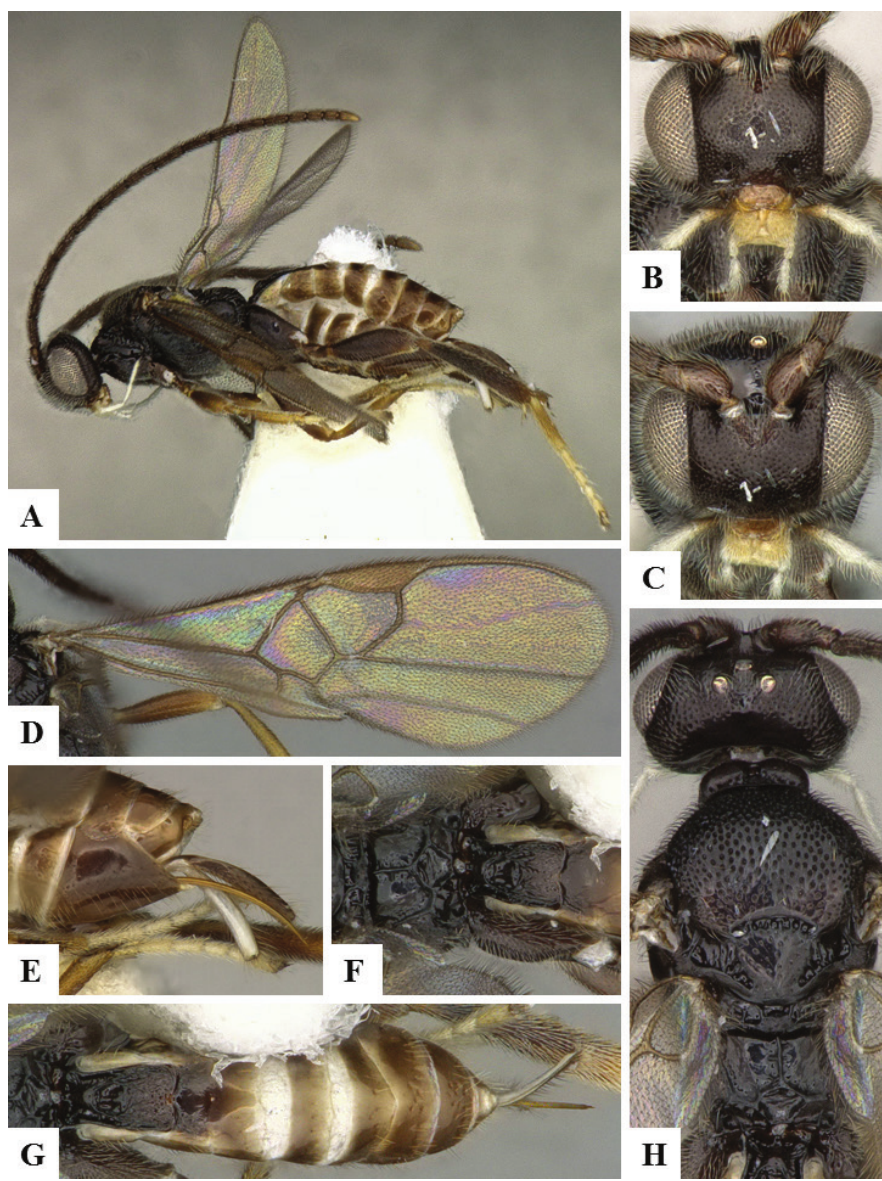
Figure 9. Austinicotesia indonesiensis female holotype. A Habitus B Head fronto-ventral C Head front- al D Fore wing E Ovipositor and ovipositor sheaths F Propodeum and tergite 1 G Metasoma dorsal H Head and mesosoma,